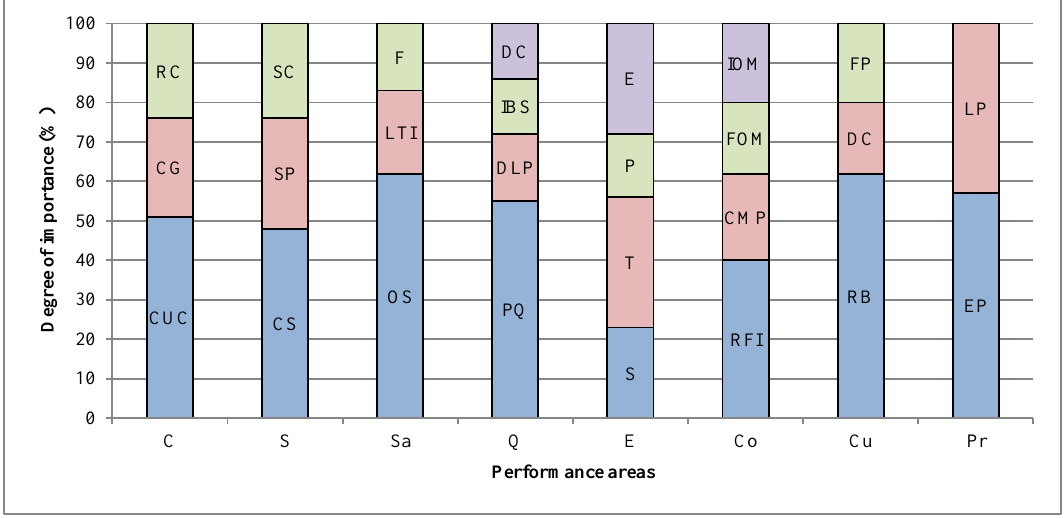
Figure 3. Weights for performance